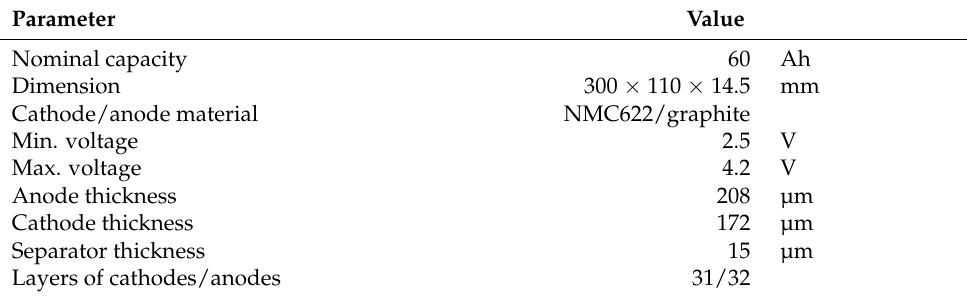
Table 1. Specifications of the tested cell.